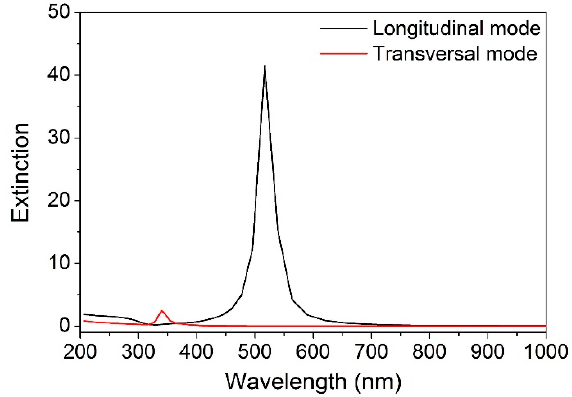
Figure 2. The calculated extinction spectra of a silver nanorod with a diameter of 30 nm and a length of 100 nm.